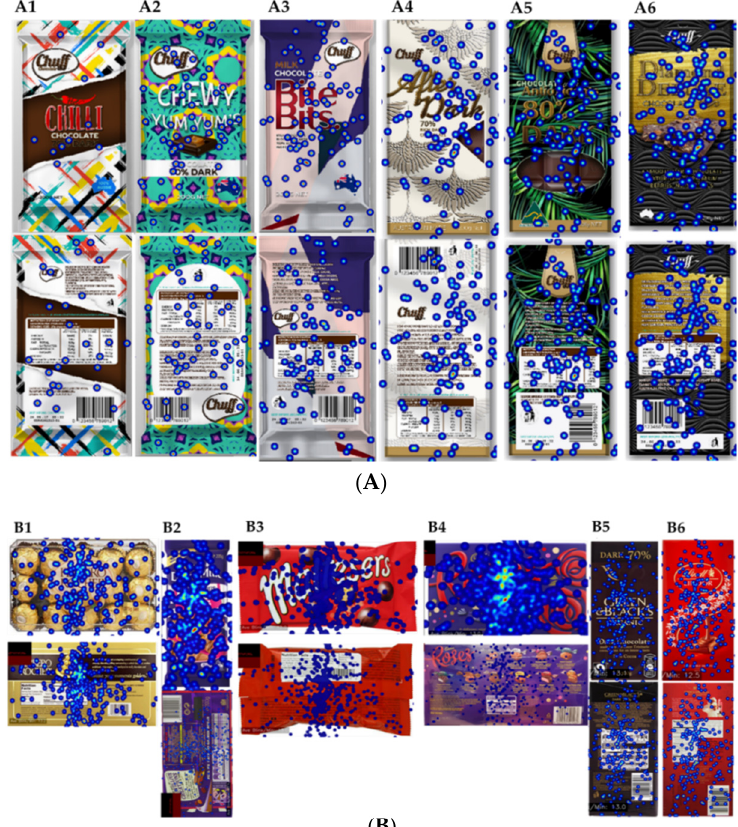
Figure 4. Heatmaps of ( A ) novel and ( B ) familiar packaging concepts for front and back packages: red, the highest number of fixations; orange, second highest number of fixations; yellow, third highest number of fixations; blue, least number of fixations. ( A ) (A1) bold, (A2) fun, (A3) every day, (A4) special, (A5) healthy, and (A6) premium. ( B ) (B1) Ferrero Rocher, (B2) Cadbury Marvellous Creations, (B3) Maltesers, (B4) Roses, (B5) Green & Black’s, and (B6)